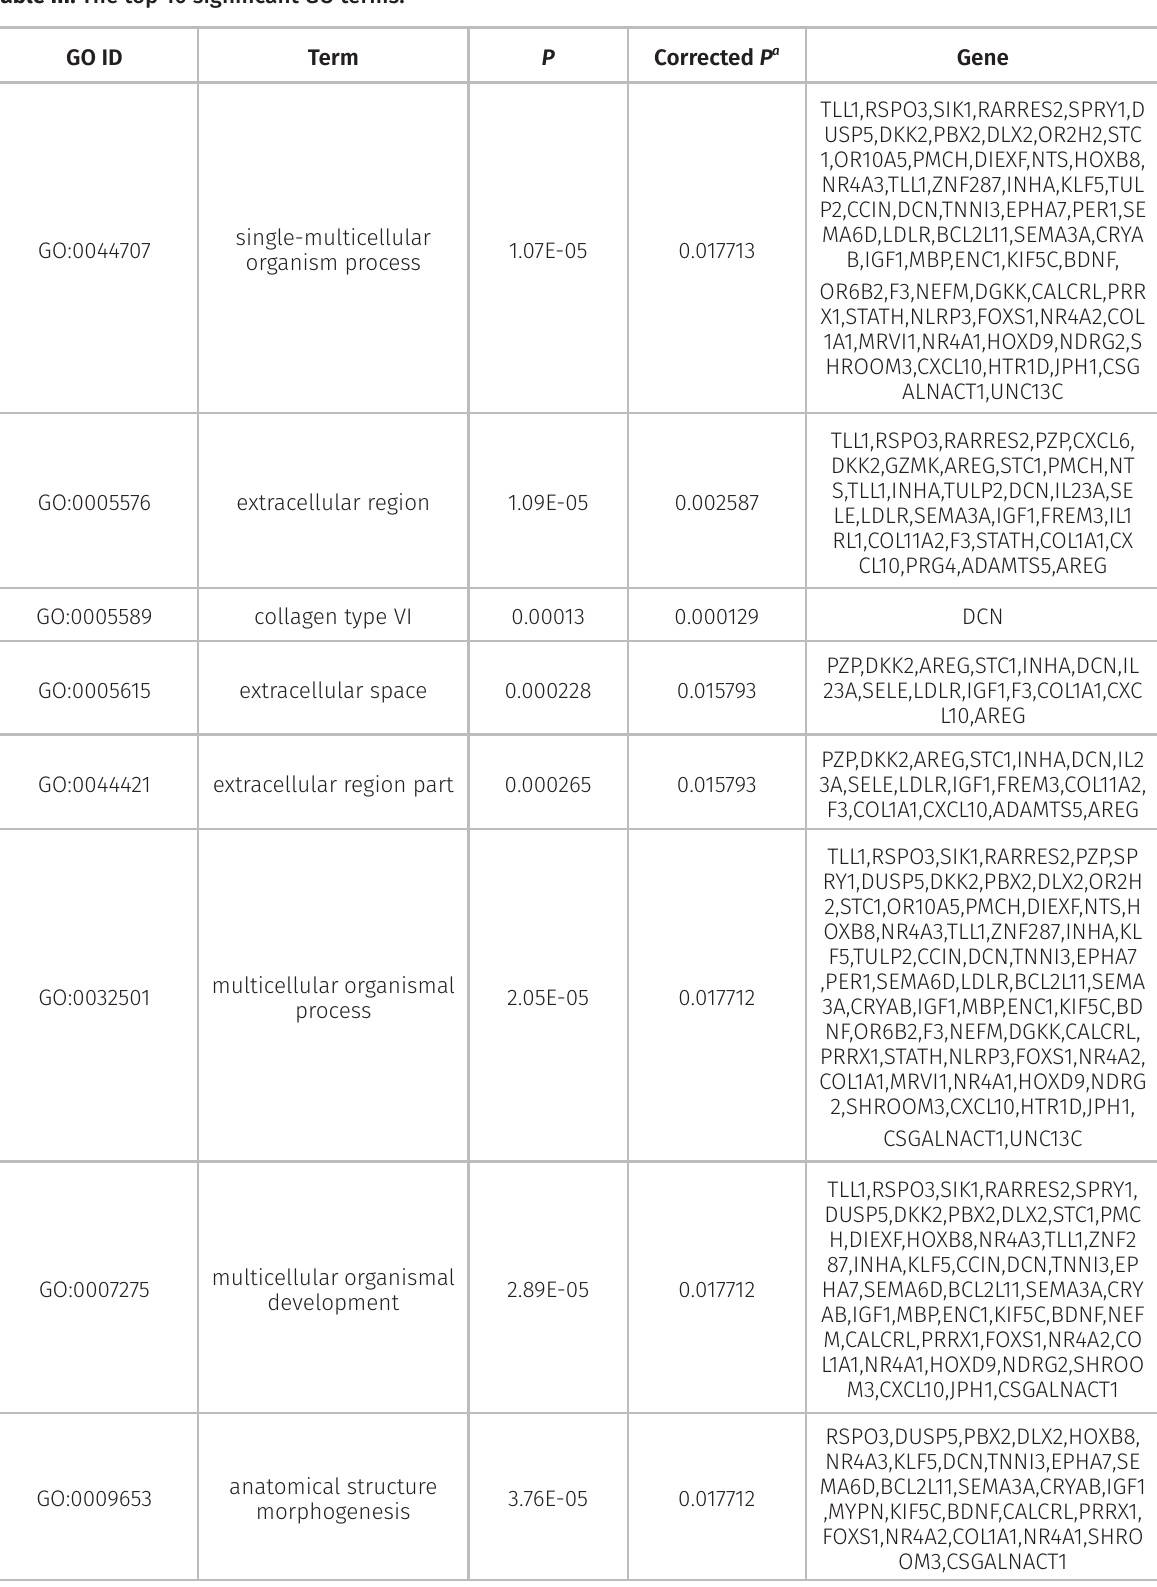
Table III. The top 10 significant GO